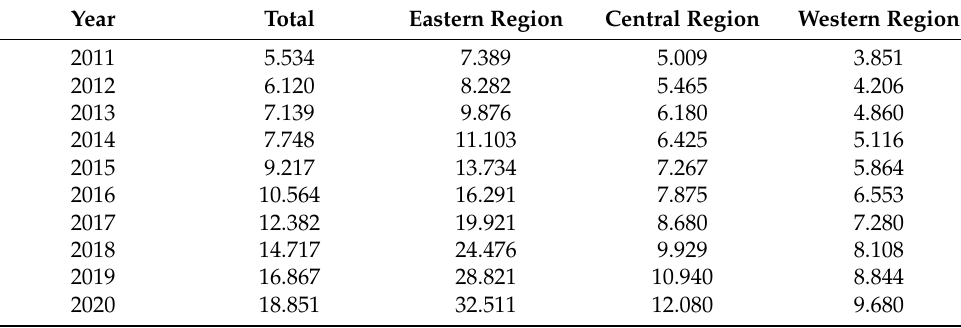
Table 3. Average development level of China’s digital economy from 2011 to